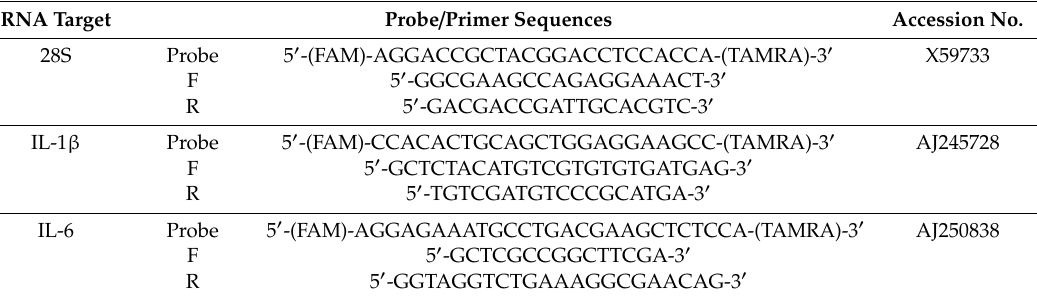
Table 1. Primer and probe